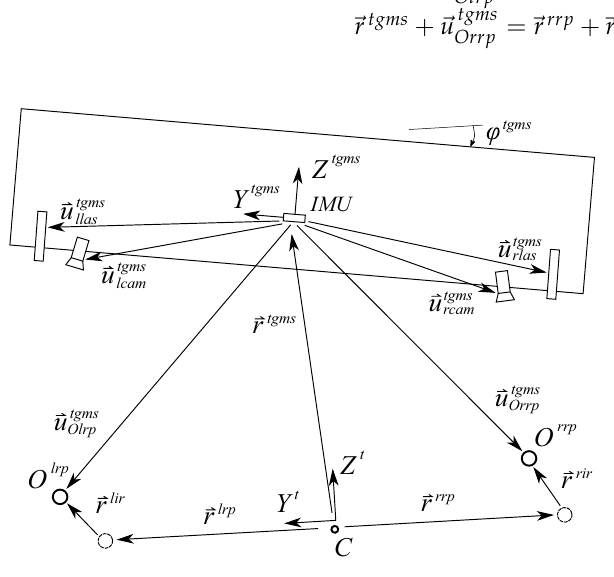
Figure 7. Planar view of the